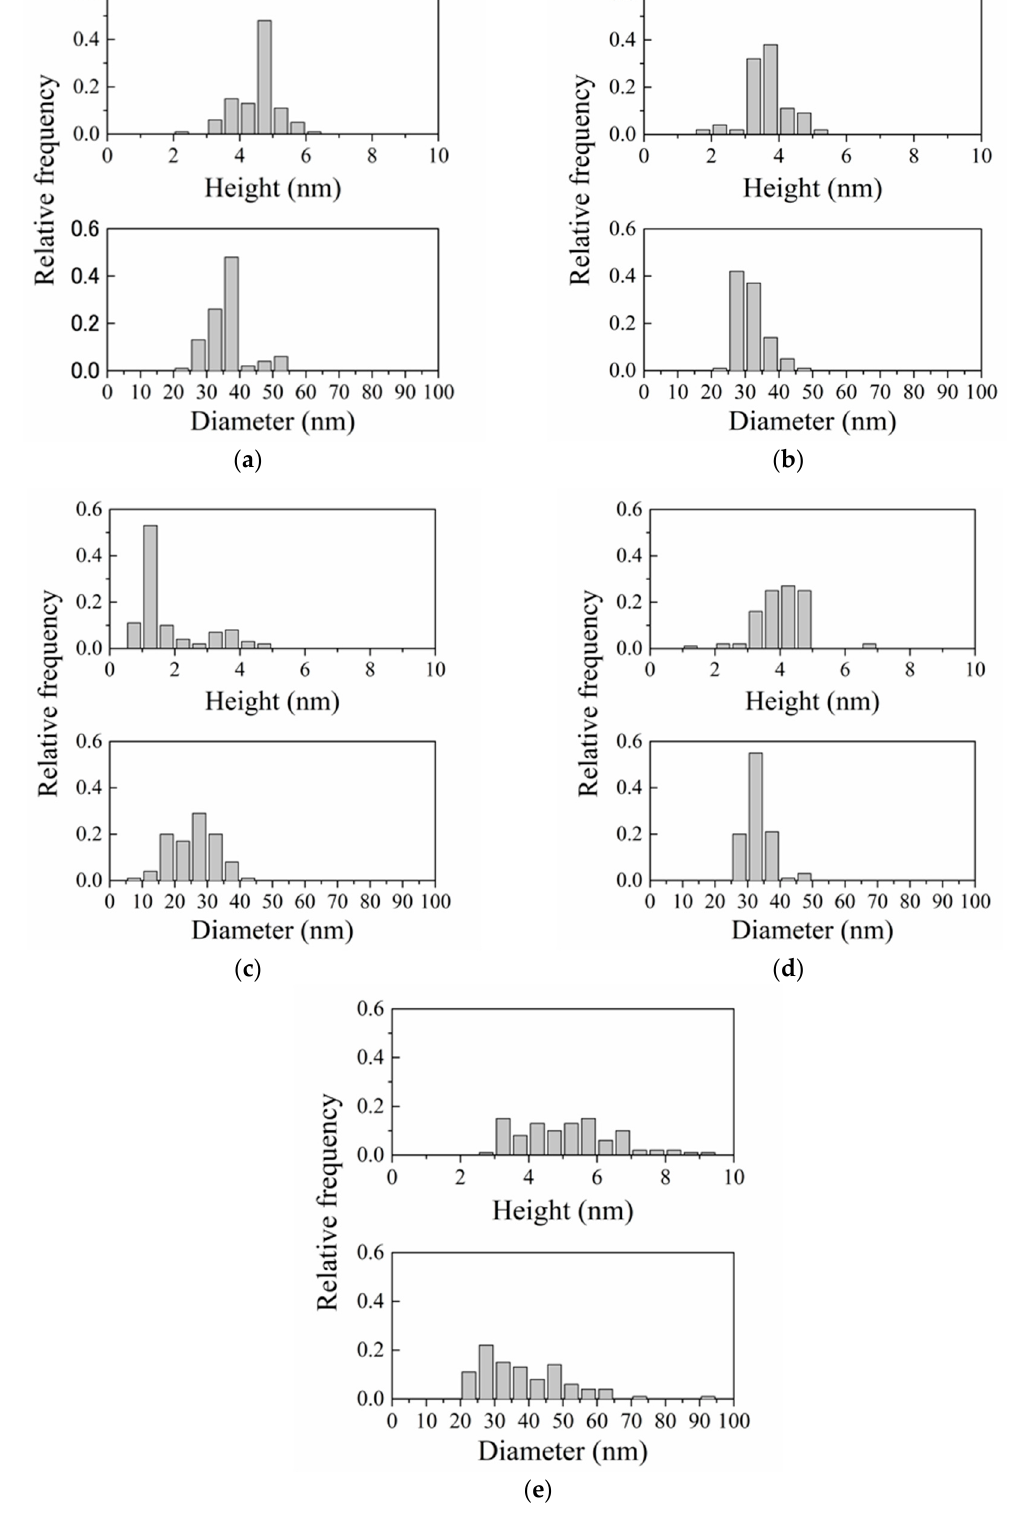
Figure 3. Histograms of lateral size and height of quantum dots (QDs): irradiated with As for ( a ) 240 s at 470 °C, ( b ) 240 s at 450 °C, ( c ) 240 s at 430 °C, ( d ) 120 s at 470 °C, and ( e ) 480 s at 470 °C.